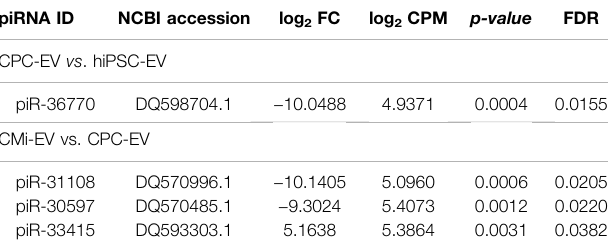
TABLE 1 | Differentially expressed piRNA between CPC-EV vs. hiPSC-EV and CMi-EV vs. CPC-EV obtained by small RNA-seq. FC, fold change; CPM, counts per million; FDR, false discovery